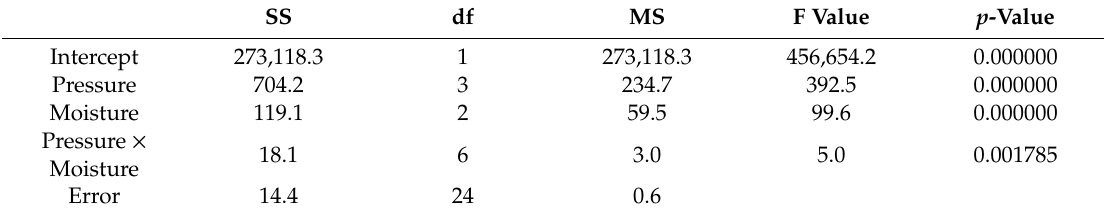
Table 3. Two-way